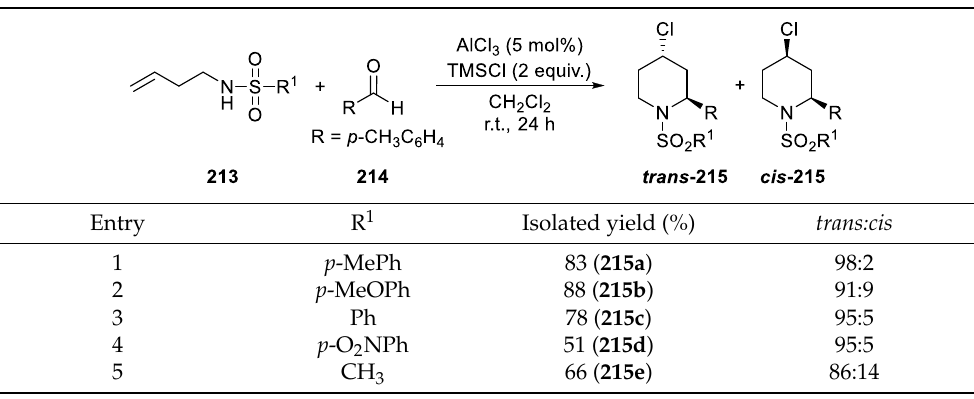
Table 7. AlCl 3 -catalyzed Prins reactions of 4-methylbenzaldehyde with different sulfon- Table 7. AlCl 3 - catalyzed Prins reactions of 4 - methylbenzaldehyde with different sulfonamides amides substrates. substrates.